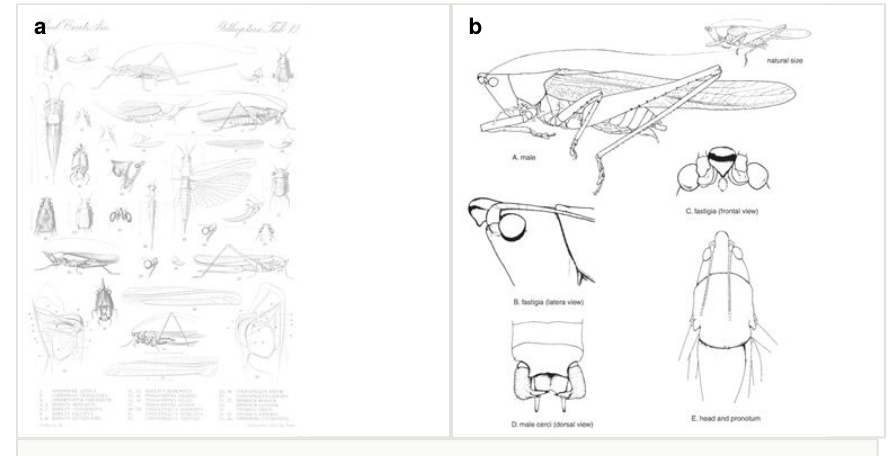
Figure 6. Time series of taxonomic illustrations depicting various katydid (bush crickets) species (Insecta: Orthoptera: Tettigoniidae) in standard views. a : Various conocephaline katydid species, from Saussure (1893) (plate 19: 1, 2, 4, 15, 23, 28, habitus of female, lateral view; 3, 13, habitus, dorsal view; 5, 6, 11, 17, 18, 21, 22, 25, 30, head region, dorsal view; 7, 8, 10, 12, 14, 31, female ovipositor, lateral view; 9, 29, 32, right forewing; 16, 19, 26, head region, frontal view; 20, 24, 27, head region, lateral view; 33, tambourine of left forewing, detail; 34, tambourine of right forewing, detail). Image available from Biodiversity Heritage Library (biodiversitylibrary.org/item/14636#page/484/mode/1up). b : Neoconocephalus a ffi nis , after Naskrecki (2000) ( fi g. 12: A, male habitus, lateral view; B, head region, lateral view; C, head region, frontal view; D, male cerci, dorsal view; E, head region, dorsal